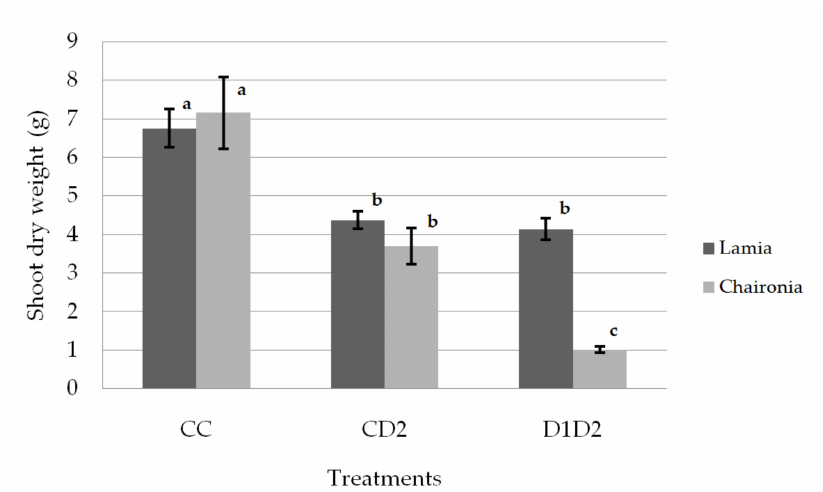
Figure 2. Shoot dry weight on day 133. Bars show the mean of the biological replicates ± SE; lower case letters indicate significant di ff erences between means ( p < 0.05).